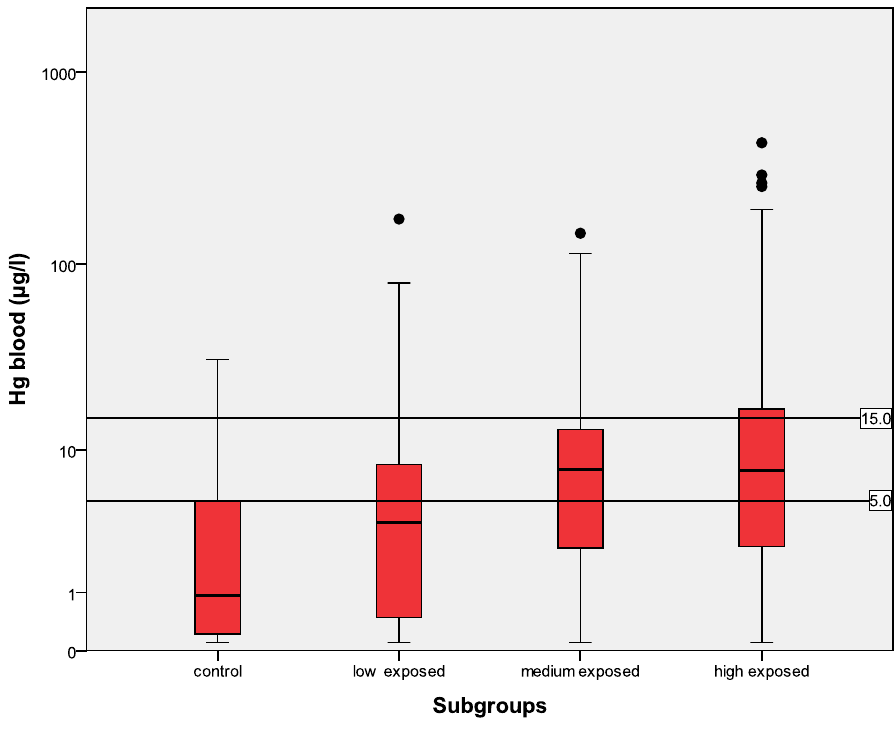
Figure 3. Blood mercury concentrations in four exposure groups (threshold values HBM I